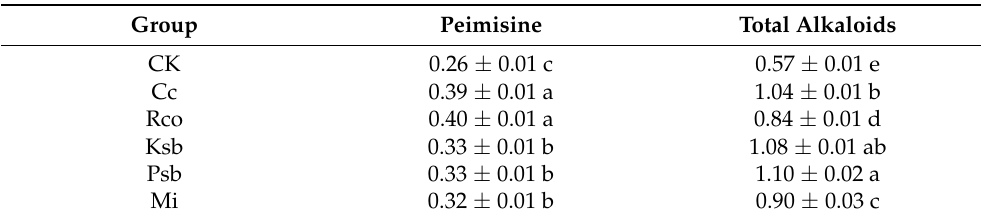
Table 5. The alkaloid content of the F. taipaiensis bulbs treated with different microbial inocula (mg · g − 1